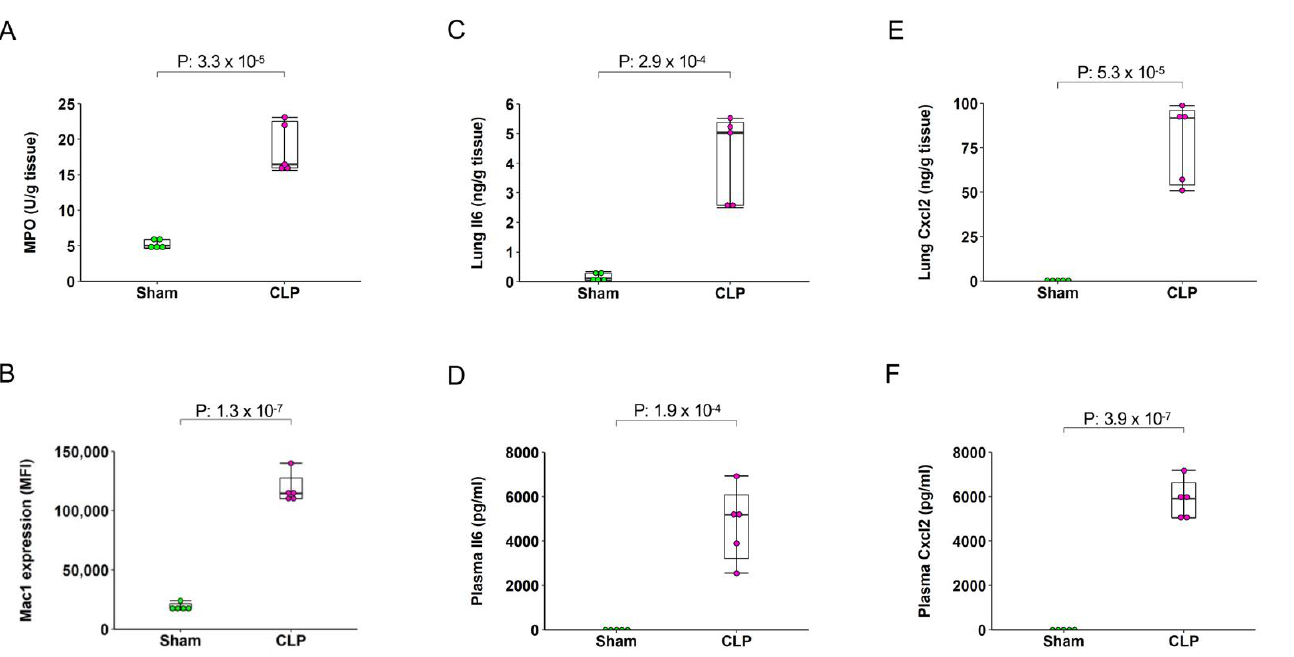
Figure 2 . Tissue and systemic inflammation after induction of abdominal sepsis. ( A ) Pulmonary MPO; ( B ) Il6; ( C ) Cxcl2; ( D ) Mac1 expression on circulatory neutrophils; ( E ) plasma Il6 and ( F ) plasma Cxcl2. Samples were collected 4 h after sham and CLP. Box plots represent the median (25 – 75 percentile) and the whiskers extend from the minimum to the maximum levels and dots represent sample values and n = 5. p -value indicates statistical significance level.